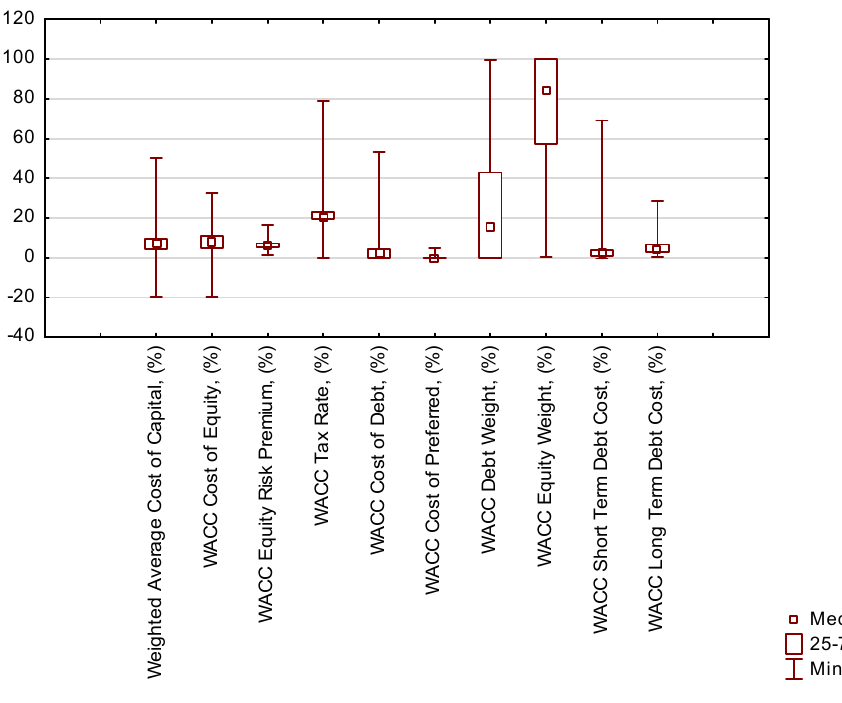
Figure 1. WACC component statistics in 2015–2019. According to the group energy source classification, the WACC cost of capital noticed the most mixed results for group A, coal (Figure 2). The smallest volatility in the WACC level was characteristic of companies in the oil-related services and equipment group, where capital cost was also low.